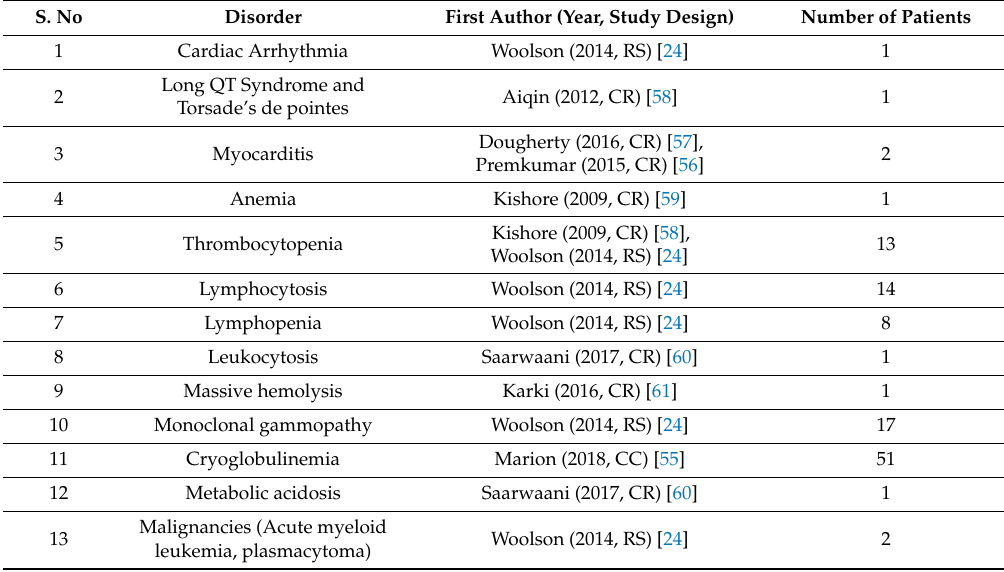
Table 2. Extra-hepatic cardiovascular and hematological manifestations of hepatitis E infection.